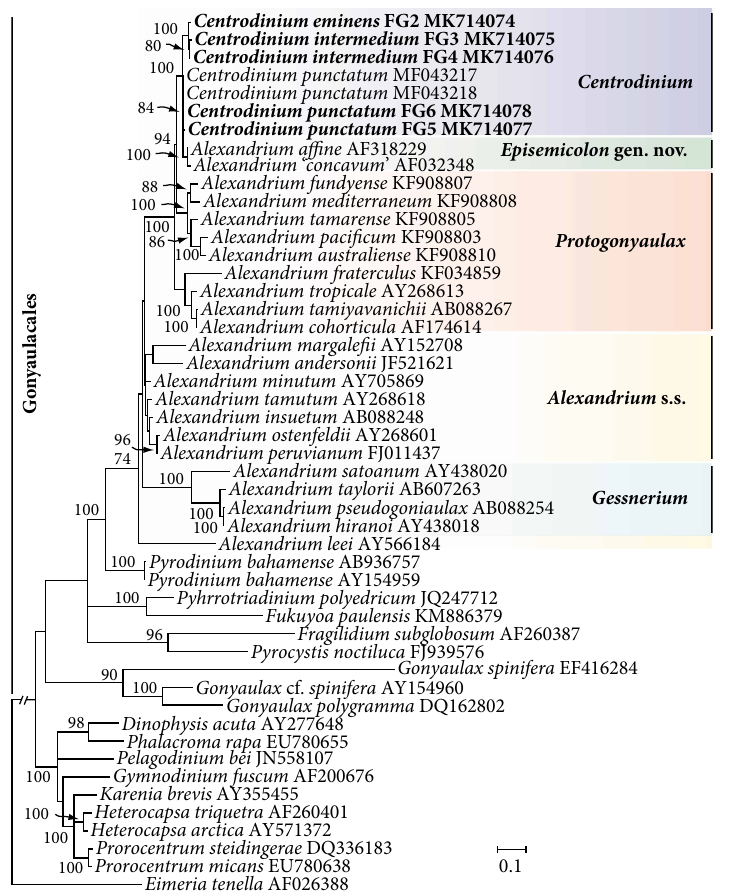
Figure 5: Maximum-likelihood phylogenetic tree of the D1-D2 domains of the LSU rRNA gene. Bootstrap support values (BP) >70 are shown. New sequences are highlighted in bold. The scale bar represents the number of substitutions for a unit branch